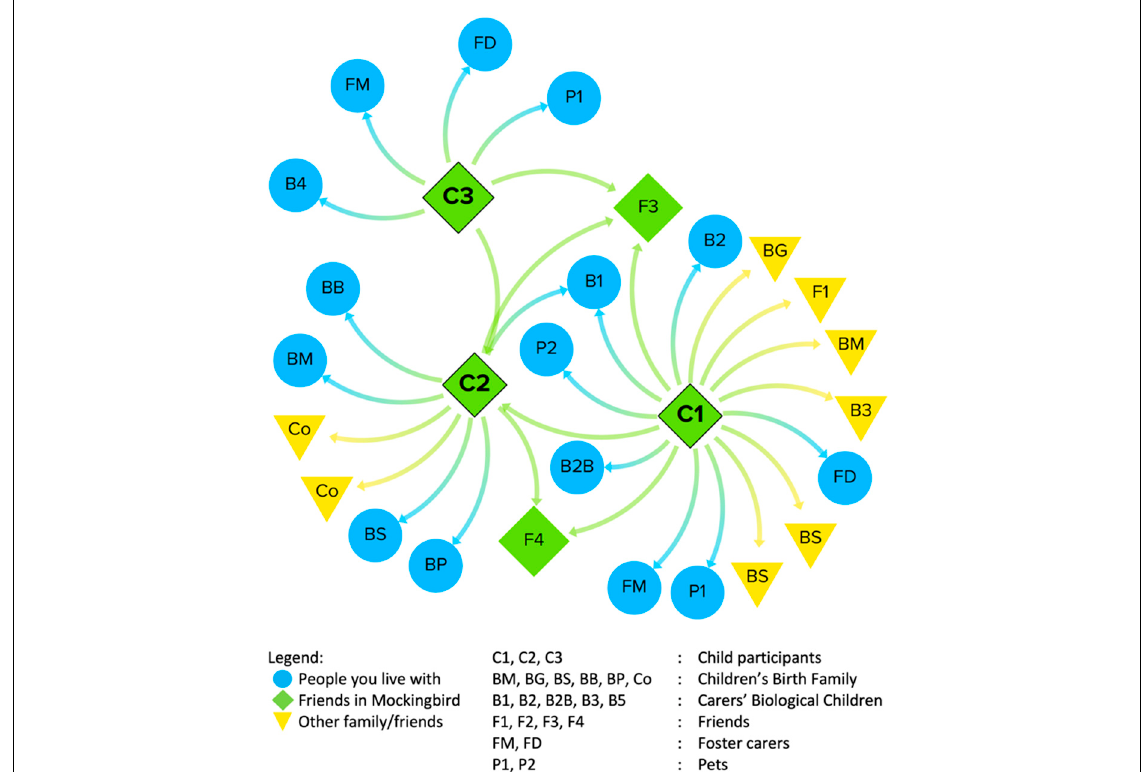
Figure 4. In-group network of three children in one Mockingbird Family constellation. Table 1. Values on selected